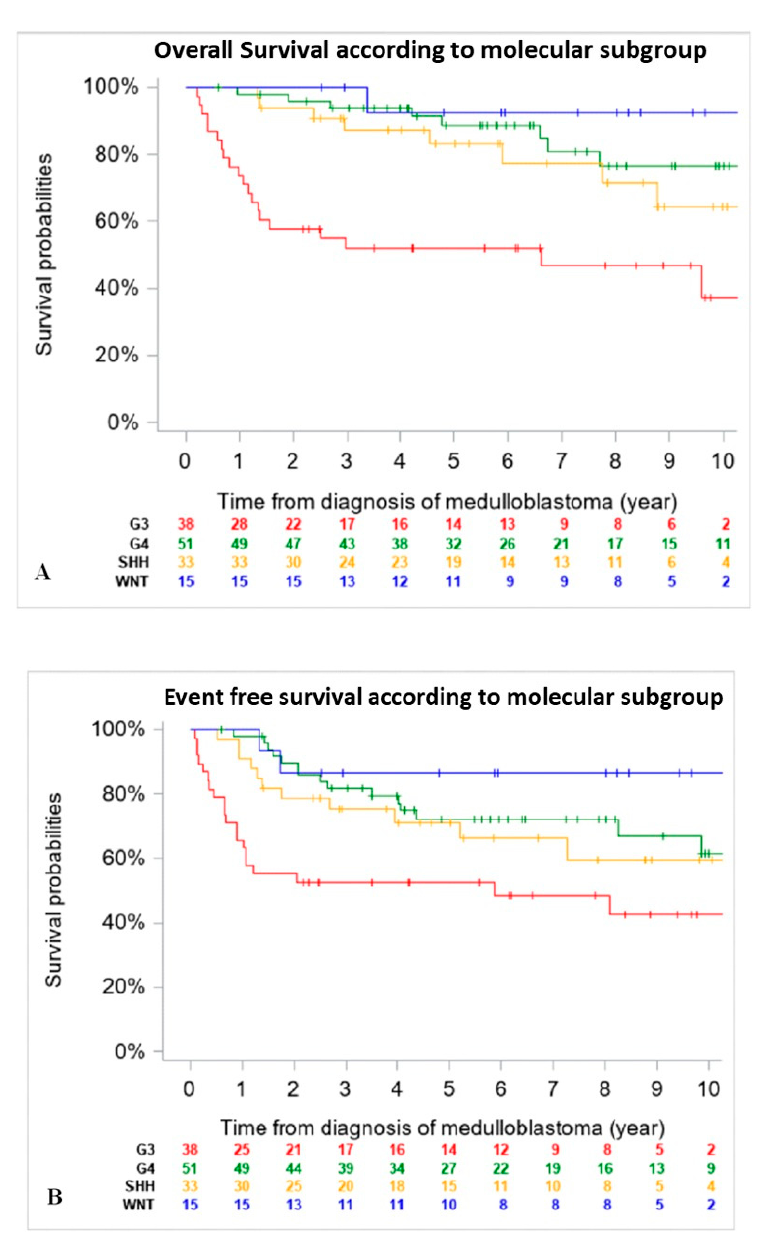
Figure 2. Overall Survival (OS) ( A ) and Event Free Survival (EFS) ( B ) of the to molecular subgroup ( n = 137) (18 patients were excluded due to missing data on DNA methylation entire cohort according to molecular subgroup ( n = 137) (18 patients were ex- subgroups at diagnosis). ( A ): 5-year OS was 92.3% (CI 95%, 66.7–98.6%) for patients with WNT cluded due to missing data on DNA methylation subgroups at diagnosis). tumors, 83% (CI 95%, 65.6–92.6%) for SHH tumors, 88.6 (CI 95%, 75.7–95.0%) for Group 4 and 51.8% (CI 95%, 36.3–67.0%) for Group 3 MB. ( B ): 5-year EFS was 86.7% (CI 95%, 62.1–96.3%) for patients with WNT tumors, 71.3% (CI 95%, 53.6–84.2%) for SHH tumors, 72.2% (CI 95%, 57.9–83.1%)